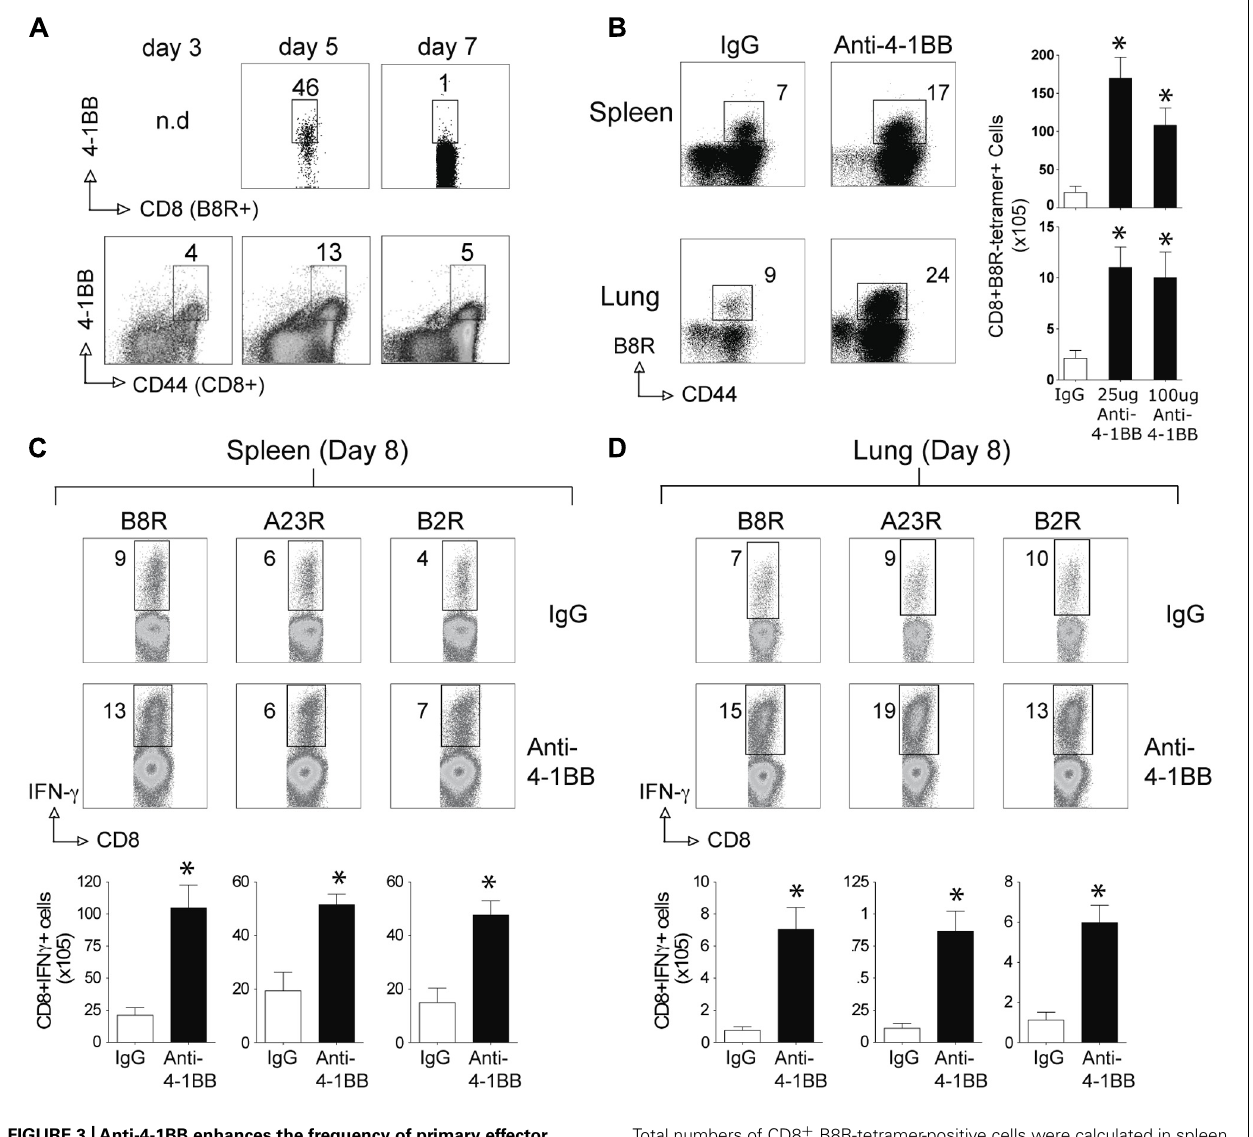
Total numbers of CD8 + B8R-tetramer-positive cells were calculated in spleen (right). (C,D) CD8T cell functionality in the spleen (C) and lung (D) was assessed by intracellular IFN- γ staining after stimulation with the indicated VACV peptides.Top: Representative plots of cytokine staining, gating on CD8 + T cells. Bottom:Total numbers of CD8 + IFN- γ + cells per tissue.The results are means and SEM ( n = 4 mice/group) from one experiment. Similar results were obtained in two separate experiments. Statistical significance. * p <